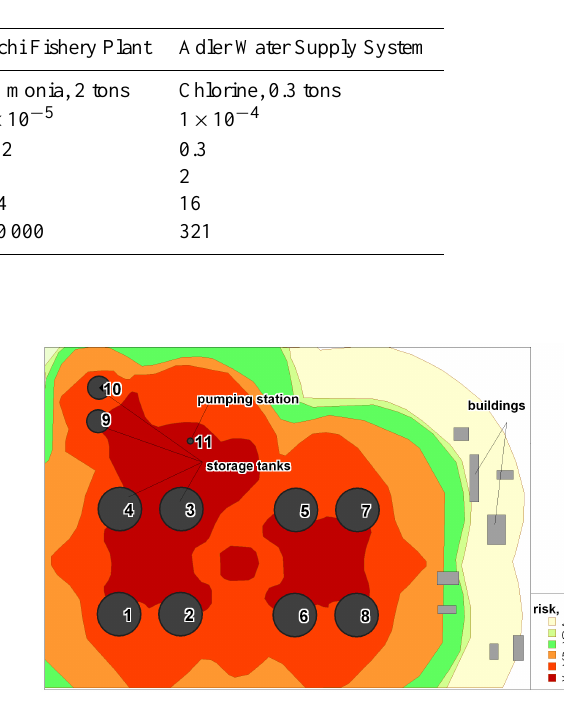
Fig. 7. Zoning of the oil storage tank farm’s territory according to the level of individual